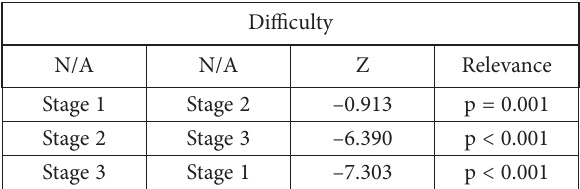
Table 4. Dunn’s test results for “Difficulty” variable